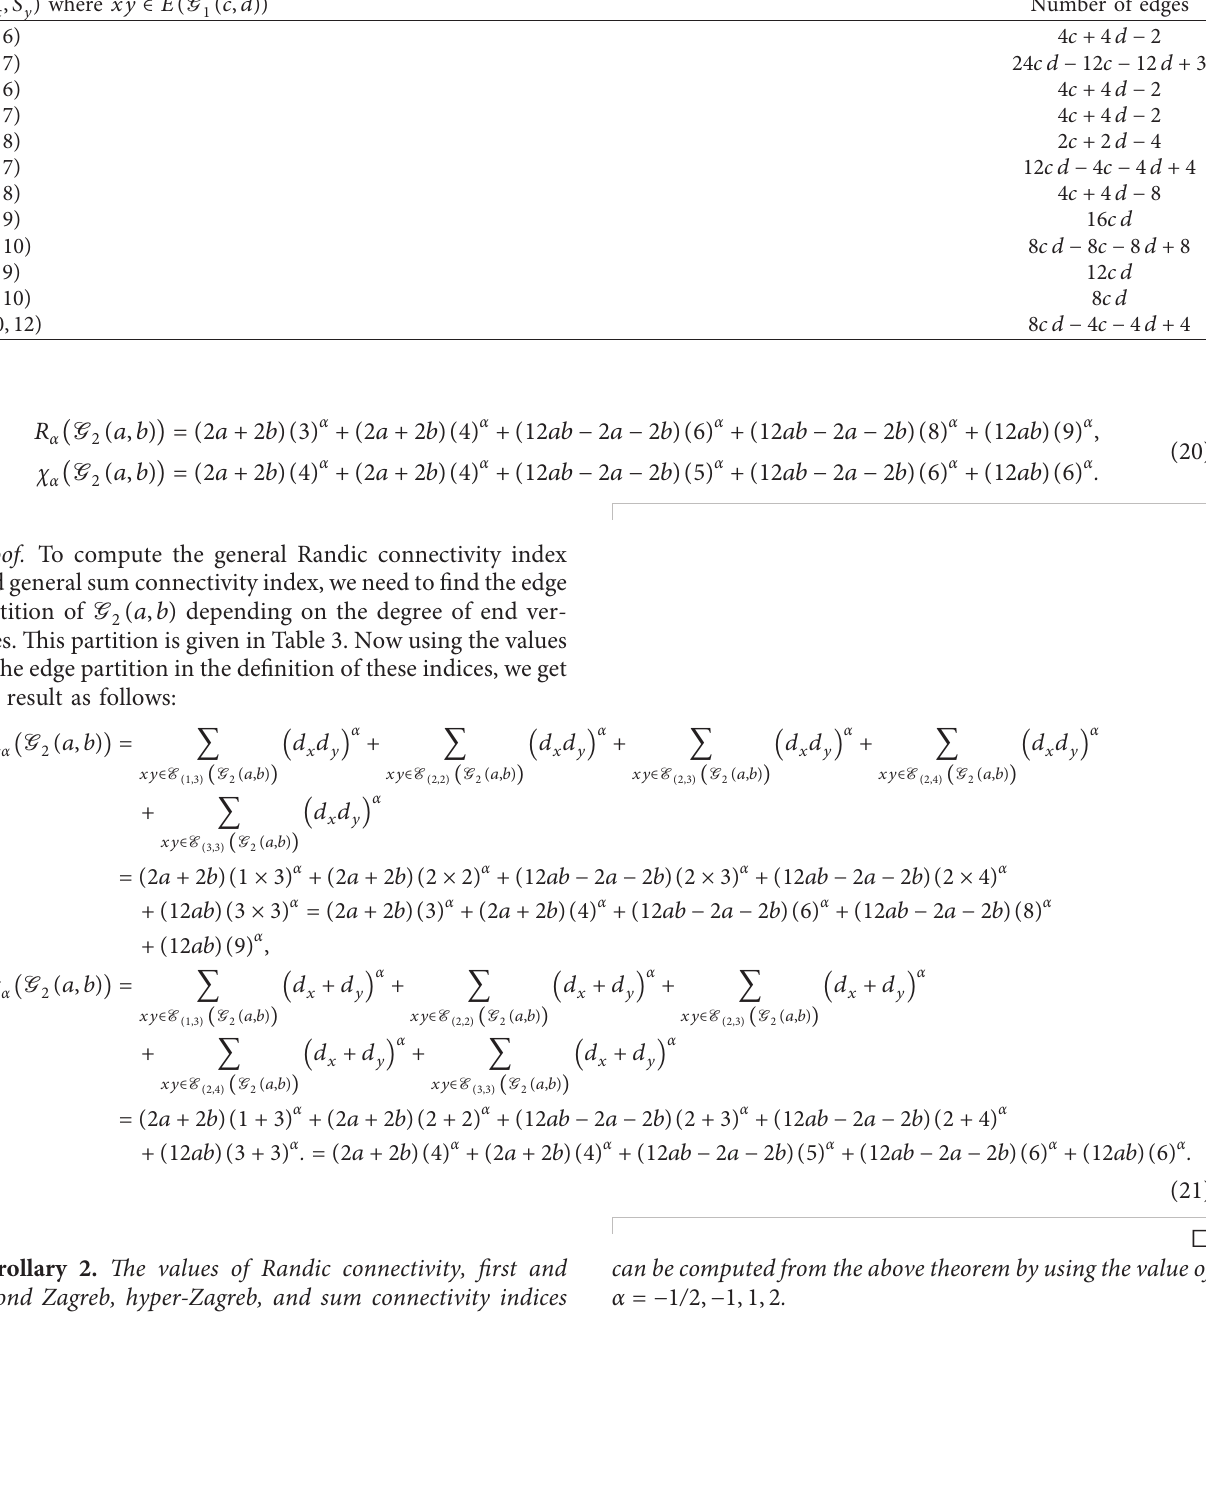
Table 2: The partition of edge set of graph G ( c, d ) based on sum of degrees of neighbor vertices of end vertices of each edge. 1 , S ) where xy ∈ E ( G ( c, d )) Number of ( S x y 1